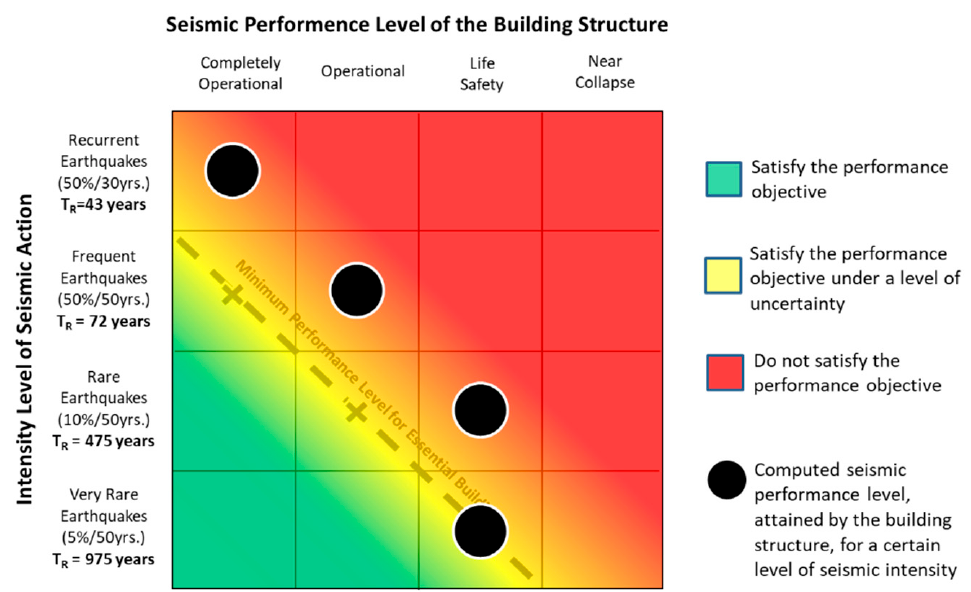
Figure 9. Seismic performance matrix with identification of the admissible and non-admissible zone (matrix of the school ES José Gomes Ferreira ).